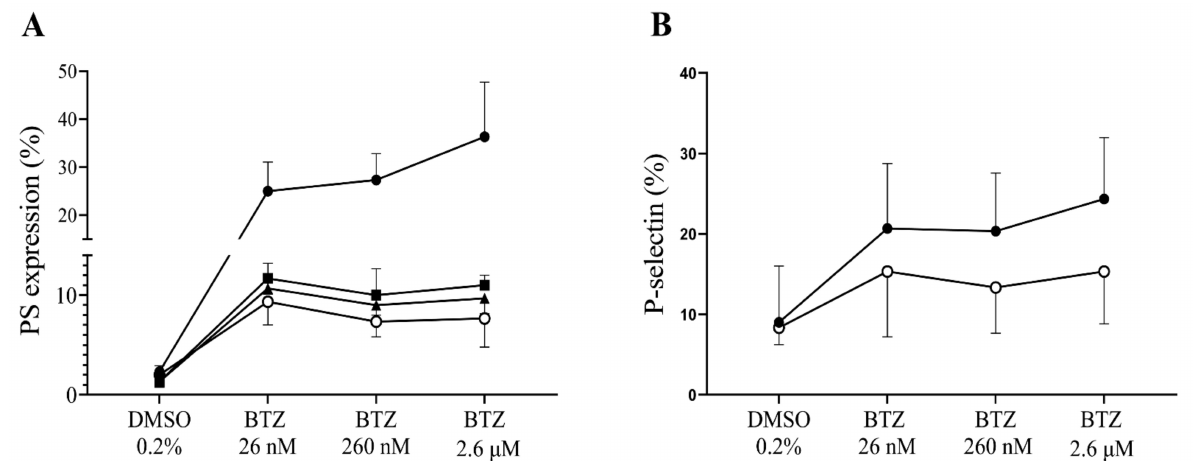
Figure 6. The effect of BTZ on human GFPs is neutralized by HSA. In panel ( A ), GFPs were supplemented with 10, 20 and 40 mg/mL of HSA or buffer before incubation with BTZ for 60 min. In panel B, 40 mg/mL of HSA was used and pretreatment with BTZ was performed for 15 min. Platelet PS and P-selectin expression levels were analyzed by flow cytometry using annexin V and anti-CD62P antibody, respectively. The expression of PS ( A ) and P-selectin ( B ) was induced in the BTZ-treated platelets without albumin (represented by line with solid circle). However, these effects were abolished with the addition of albumin (10, 20 and 40 mg/mL; represented by lines with square, triangle and open circle, respectively). Mean ± SD of 3 independent experiments is presented. BTZ: bortezomib; DMSO: dimethyl sulfoxide; PS: